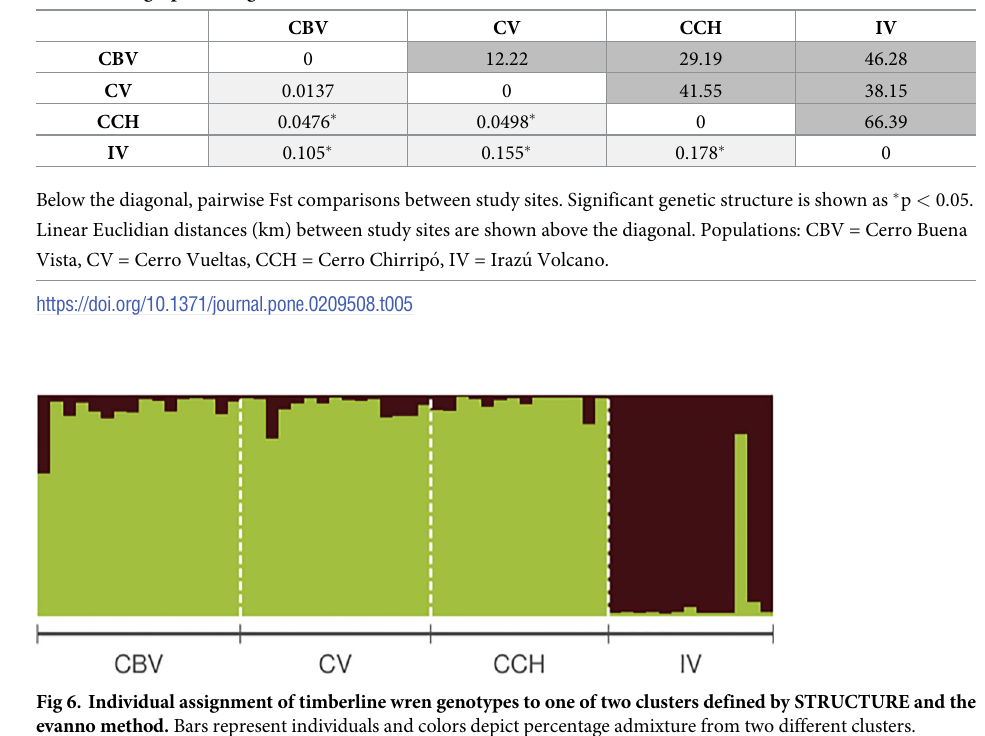
Table 5. Geographic and genetic distance matrix.